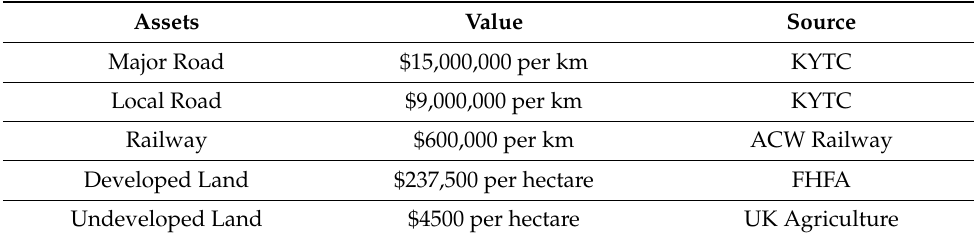
Table 3. Elements at risk and their estimated monetary value. KYTC = Kentucky Transportation Cabinet, UK Agriculture = University of Kentucky Agriculture Department, FHFA = Federal Housing Finance Agency, ACW = Aberdeen Carolina & Western Railway. Calculations were performed using United States customary units (miles) and converted to metric. Values are in U.S. dollars.